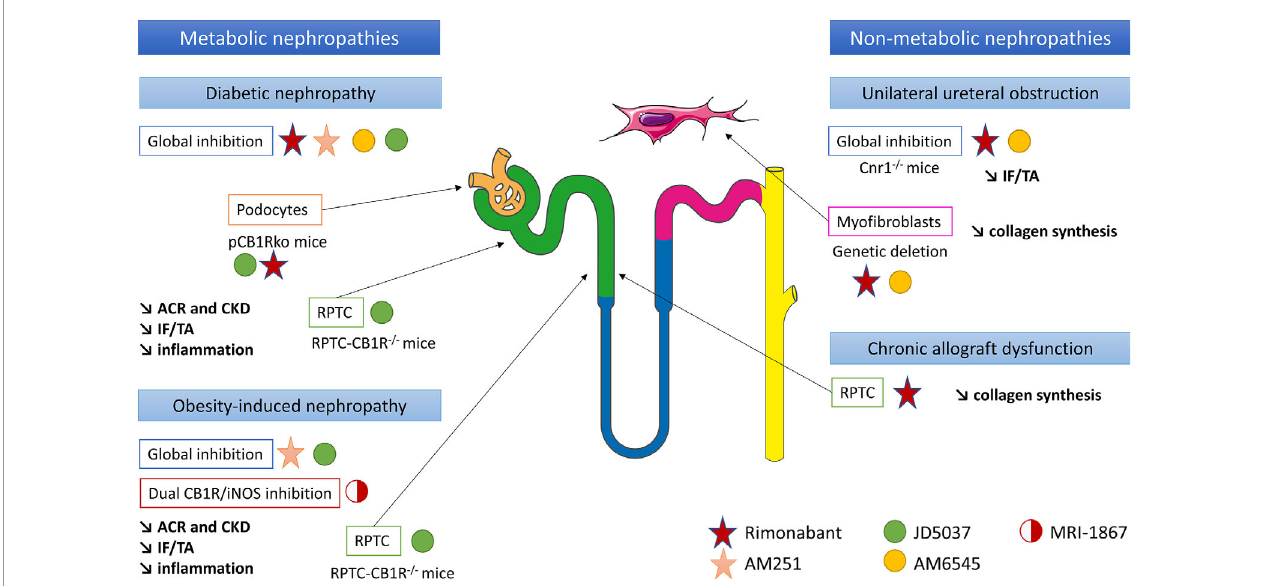
FIGURE 3 | CB1R inhibition could be a new therapeutic target in chronic kidney diseases and renal fi brosis, in both metabolic and non-metabolic nephropathies. Both in vitro and in vivo experiments have been taken into account. ACR, urinary albumin-to-creatinine ratio; CB1R, cannabinoid receptor type 1; CKD, chronic kidney disease; IF/TA, interstitial fi brosis and tubular atrophy; iNOS, inducible nitric oxide synthase; pCB1Rko, podocyte-speci fi c deletion of CB1R; RPTC, renal proximal tubular